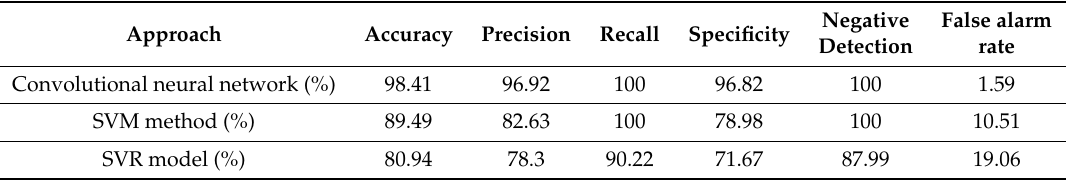
Table 35. Comparison of detection evaluation indices among the three methods for pitch system